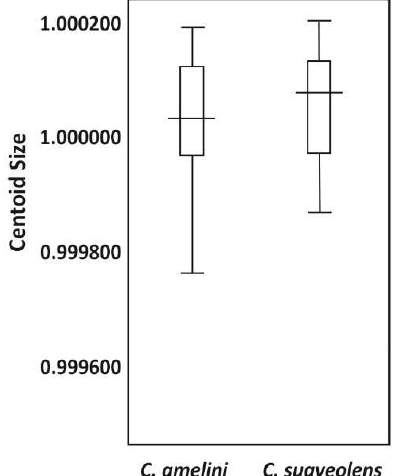
F IGURE 5. Distribution of centroid sizes between suaveolens and gmelini